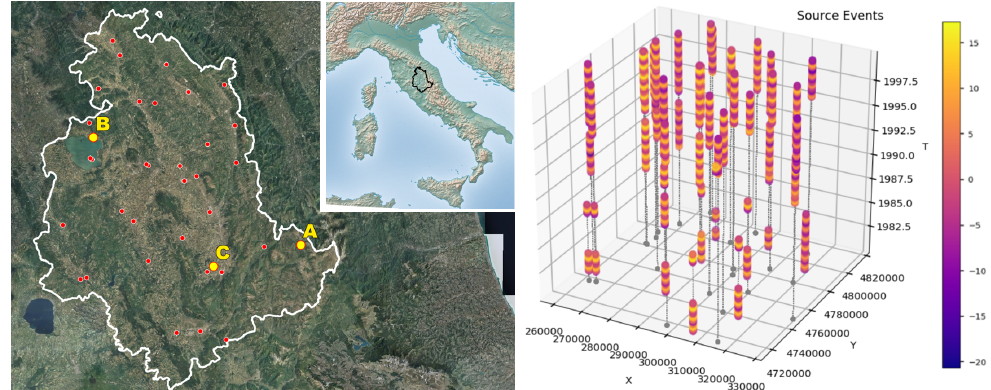
Figure 14. ( Left ): The weather stations network (red dots) in Umbria; A, B and C are referred to the actual sites of the time series of Figure 15. ( Right ): spatio-temporal distribution of the source events. Base map and boundaries from NaturalEarthData [70] and Geoportale Nazionale [71], map prepared with Qgis [72].